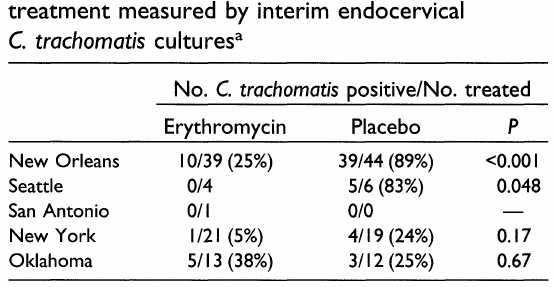
TABLE 3. Bacteriologic effect of erythromycin treatment measured by interim